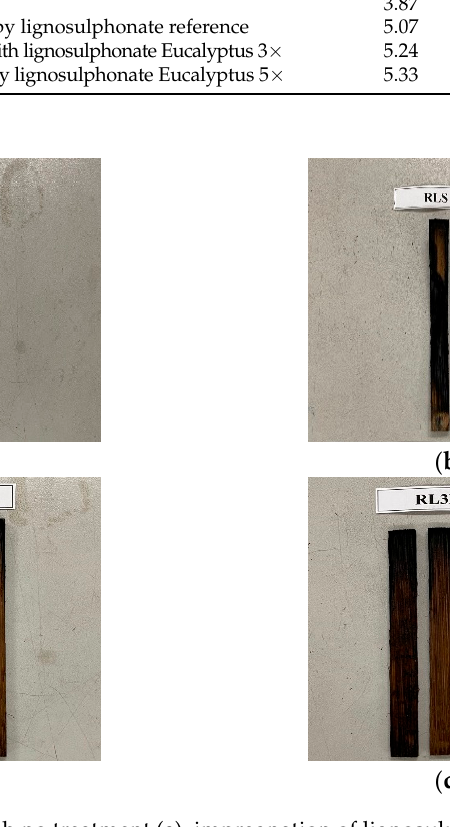
Figure 8. Rattan with no treatment ( a ), impregnation of lignosulphonate reference ( b ), Eucalyptus 3× ( c ), and 5× ( d ) washing treatments after flammability testing. Table 9. UL-94 classification of rattan with no treatment, impregnation of lignosulphonate reference, eucalyptus after 3×, and 5× of washing treatments.